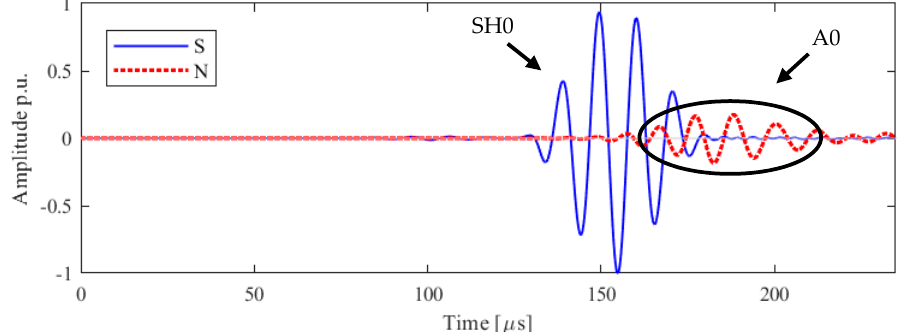
Figure 9. Configuration A numerical results of the in-plane (blue), ‘S’, and out-of-plane, ‘N’, (red) velocities along the line orthogonal to the line of vibration. Normalized data are shown: modes are identified and labelled accordingly.